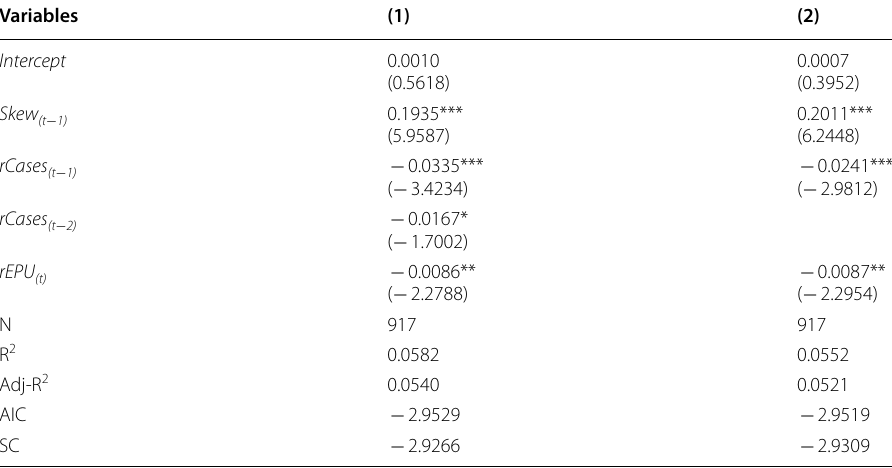
Table 6 The effects of COVID‑19 and EPU on stock market crash risk